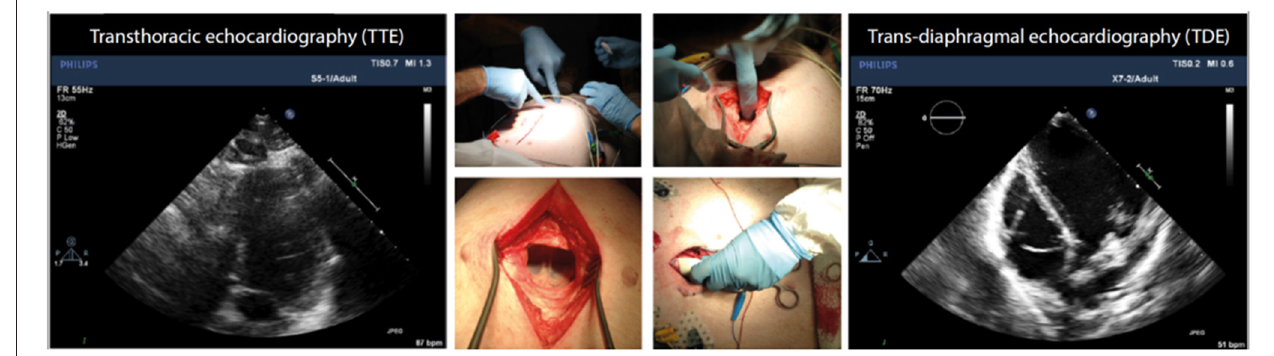
FIGURE 1 | Trans-thoracic and trans-diaphragmal echocardiographic approach (12).